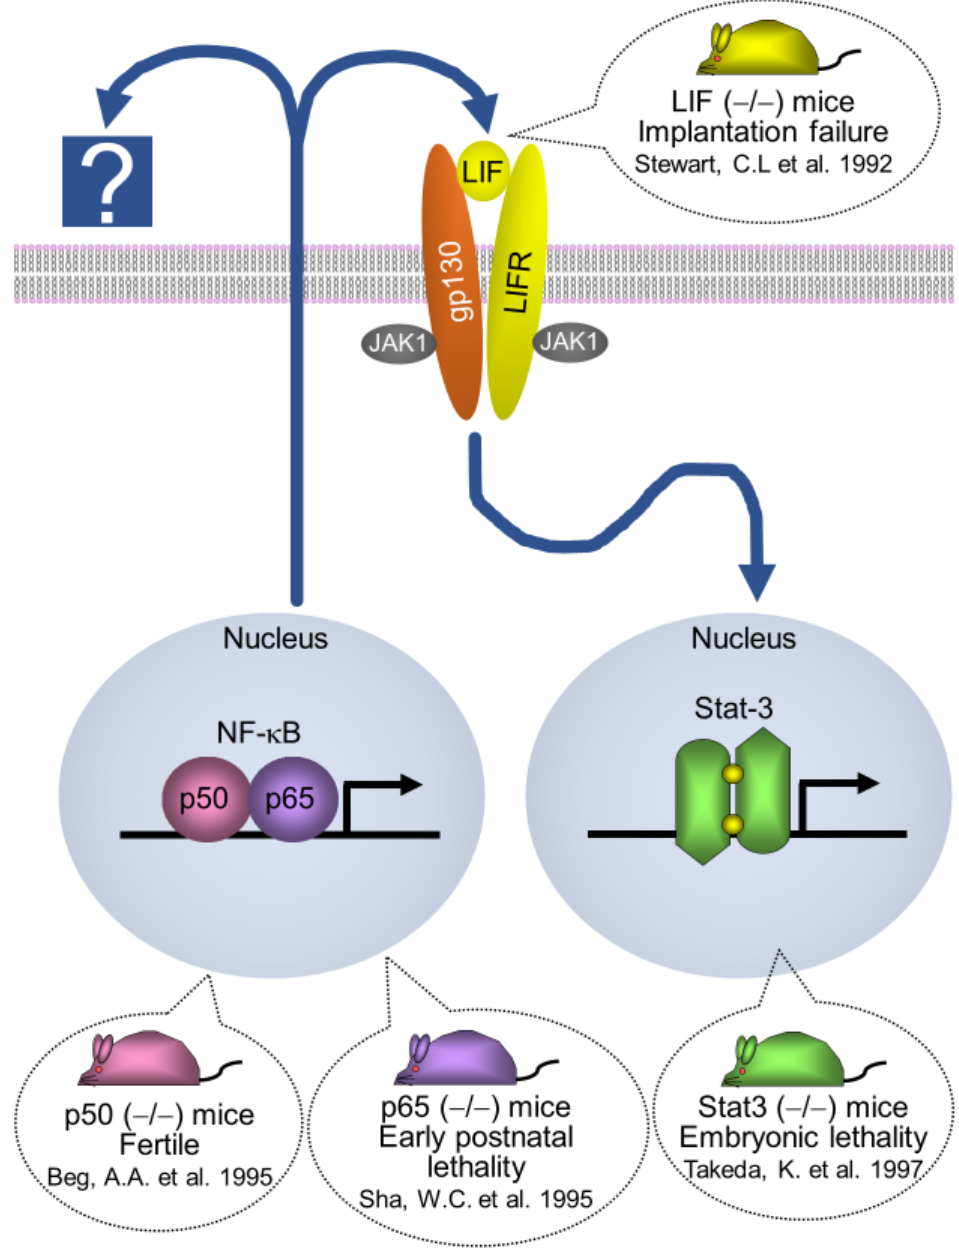
Figure 4. Molecular mechanism of implantation in mouse. NF- κ B activation determines the timing of implantation, at least in part, by controlling LIF expression. LIF recruits JAK kinases by binding to LIF receptor (LIFR)-gp 130 and, in turn, recruits the transcription factor Stat-3. NF- κ B nuclear factor-kappa B; LIF, leukemia inhibitory factor; JAK, Janus kinase; Stat-3, signal transducer and activator of transcription 3 .